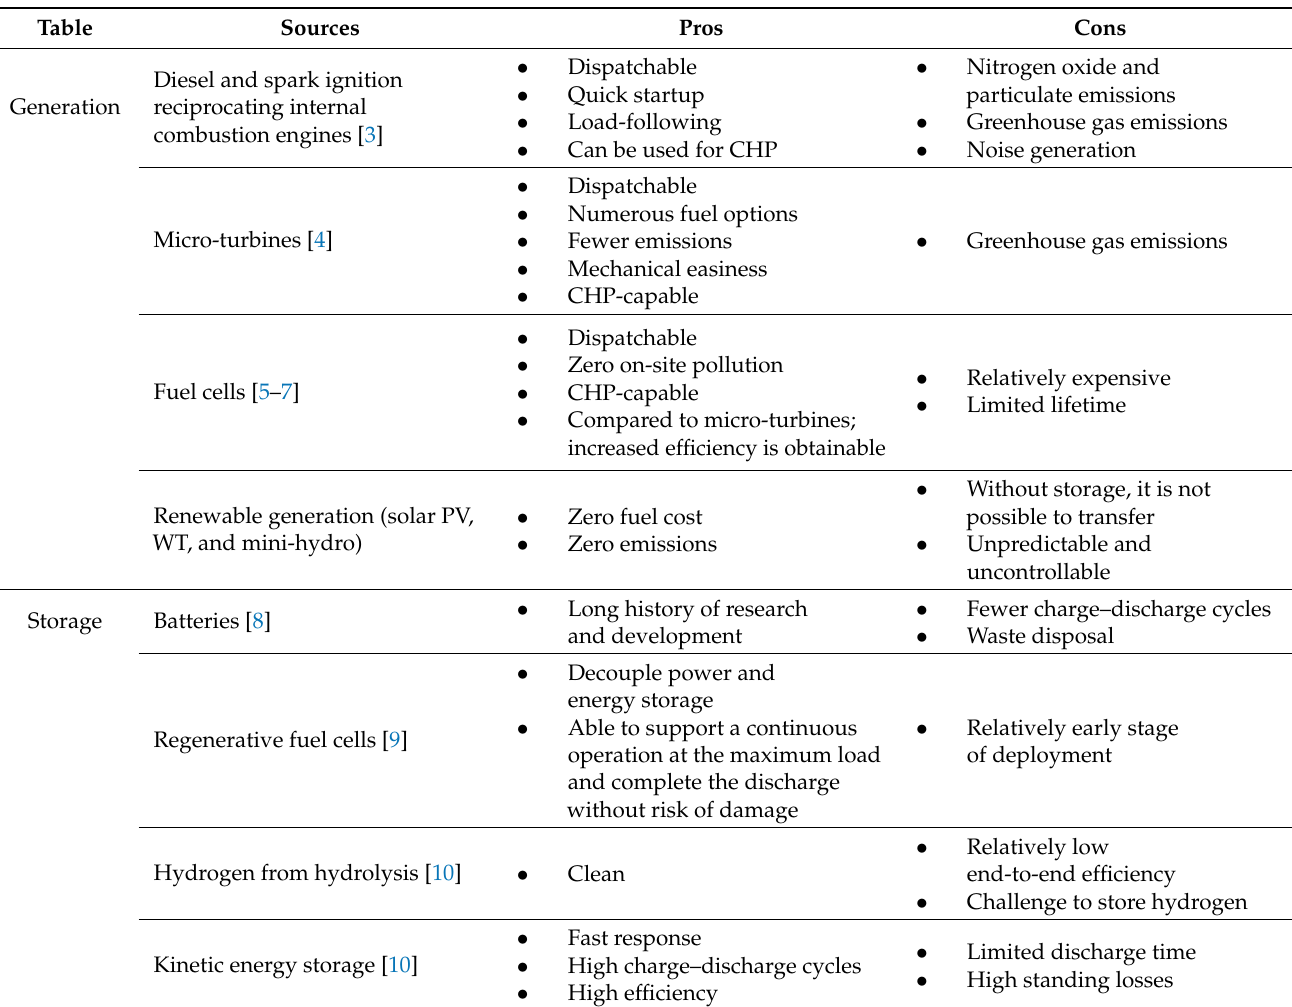
Table 1. Summary of MG generation and its storage possibilities.